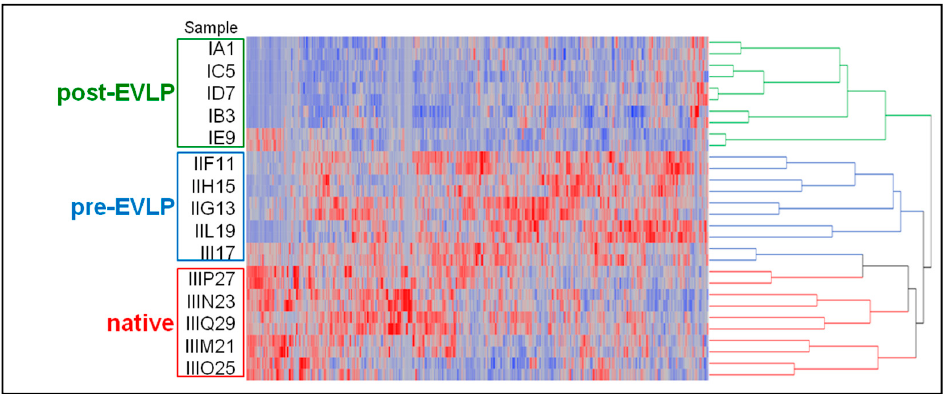
Figure 5. Hierarchical clustering obtained by Linear Discriminant Analysis (LDA). Using the average SpC values from all conditions, the post-EVLP samples were correctly segregated and 451 descriptor proteins by LDA were identified. Of note, IE9 sample, although remaining within the correct subgroup, is localized on a separate branch. The complete list of descriptor proteins extracted by LDA is reported in Supplementary Table S4. filtering criteria.